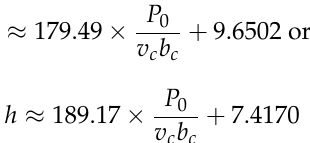
Figure 12. Relationship between laser power density and scribing depth. ( a ) Relationship between laser power density and scribing depth based on a single factor experimental data of laser power; ( b ) Relationship between laser power density and scribing depth based on a single factor experimental data of laser